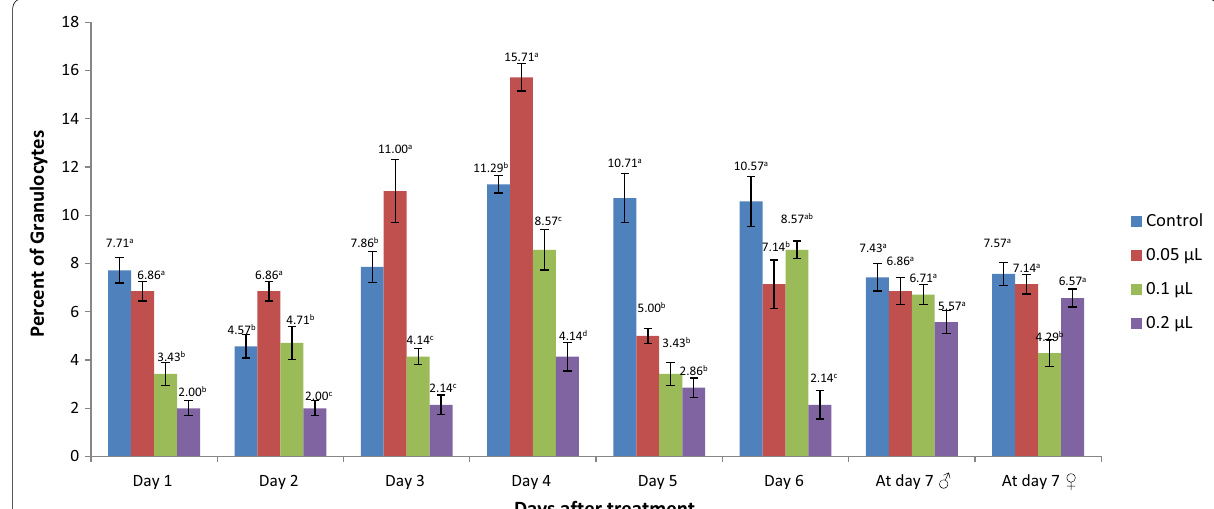
SE, Seven replicates were taken ±